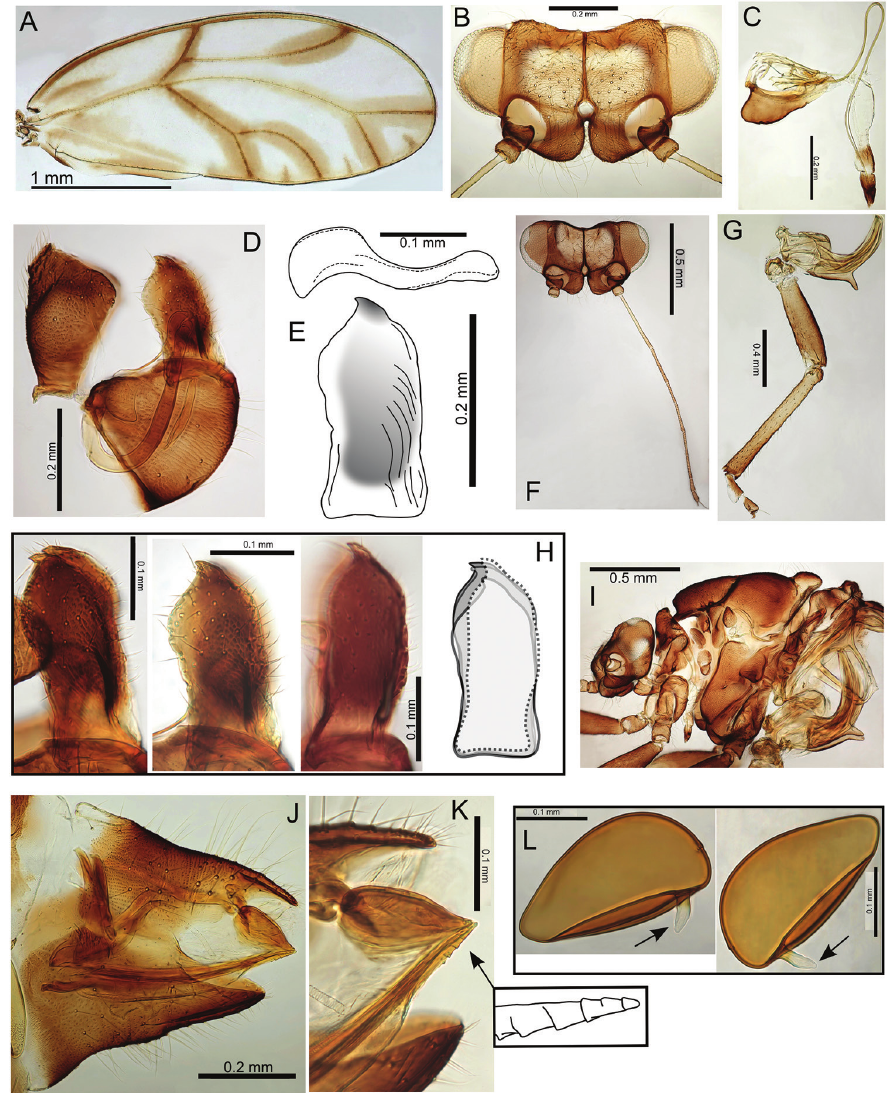
Figure 23. Pariaconus melanoneurus sp. n. A fore wing B head C proboscis D male terminalia E aedeagus and paramere F head and antenna G hind leg H male parameres and shape variation comparison I head and thorax J female terminalia K ovipositor (serrations indicated) L eggs (pedicel indicated). Egg. Light brown, smooth, apparently without microsculpturing but with a slight granular appearance, short pedicel 1/4 length from base, tail lacking (Fig. 23L). Immature.